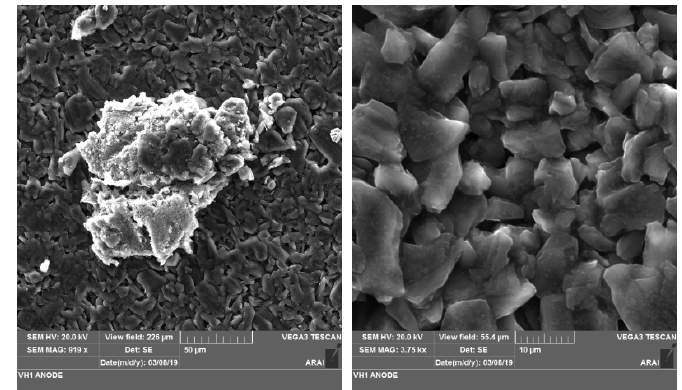
Figure 11. Anode of the cell after vibration testing.